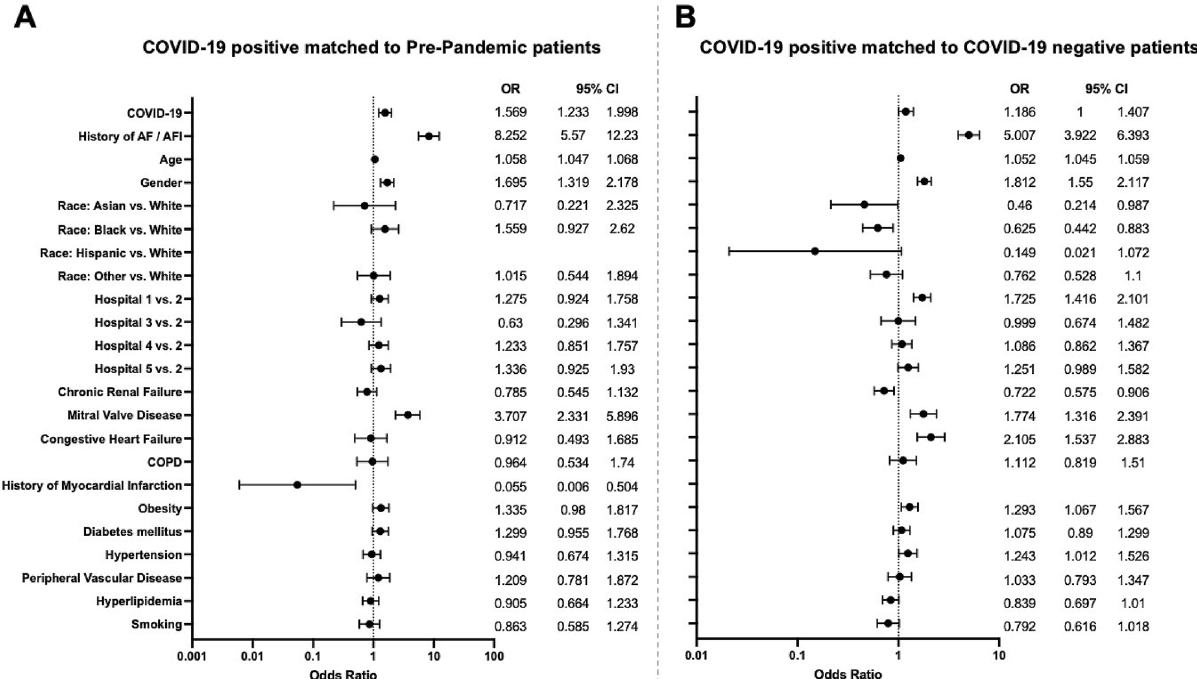
Figure 2. Multivariable logistic regression model and forest plots to determine the risk for atrial fibrillation after matching (blank rows due to insufficient data to analyze the variables Hispanic vs. White and History of myocardial infarction; “Race: Other vs White” includes Hispanic for the COVID-19 positive vs. Pre-Pandemic model; AF atrial fibrillation, AFl atrial flutter, COPD chronic obstructive pulmonary